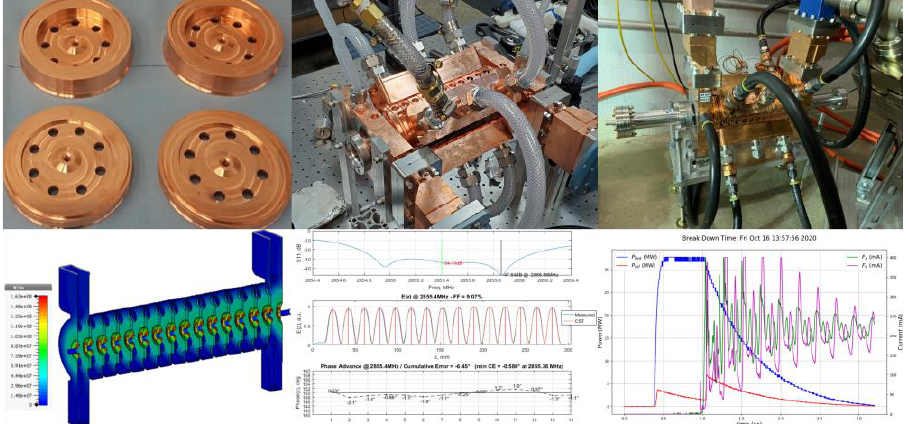
Figure 4. Design, fabrication, and high-power testing of the negative-harmonic traveling-wave structure (NHS) developed by RadiaBeam in collaboration with Argonne.